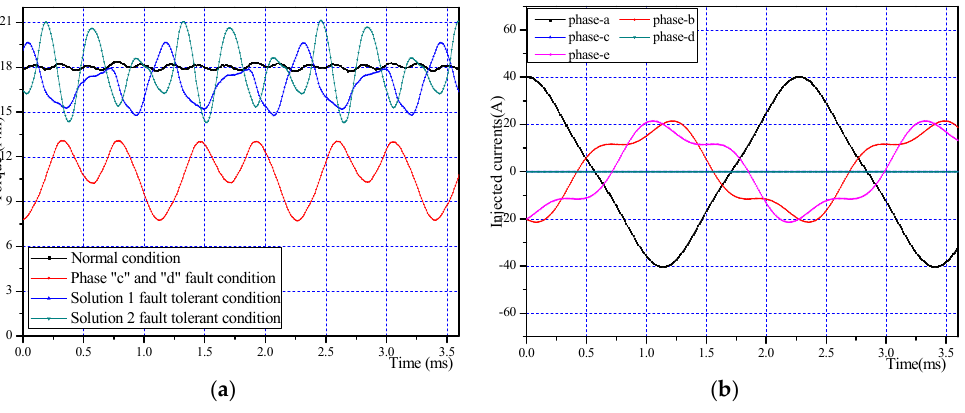
Figure 8. The motor operates under adjacent double ‐ phase open circuit conditions: ( a ) electromagnetic torque obtained by FEA; ( b ) the injected fault ‐ tolerant currents of solution 2.